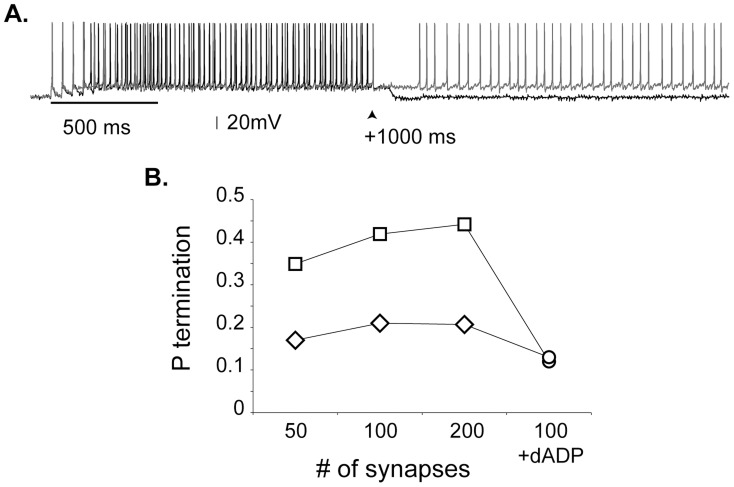
Stability of persistent activity depends on the background synaptic activity and the activation of the dADP current.
A. Indicative traces of persistent activity termination (black) and maintenance (grey) when a second stimulus (100 Hz for 100 ms) arrives 1 sec (arrow) after the inducing stimulus (dADP = 0 mV, iNMDA-to-iAMPA: 2.3). B. Probability of persistent activity termination as a function of the number of synapses delivered to the interneuron (50-100-200) under control condition (iNMDA-to-iAMPA: 2.3, dADP = 0 mV, squares) and in the presence of background synaptic input (iNMDA-to-iAMPA: 1.9, dADP = 0 mV, rhombus). dADP activation (absence of background activity: iNMDA-to-iAMPA: 1.9, dADP = 2 mV, presence of background activity: iNMDA-to-iAMPA: 1.5, dADP = 2 mV) is shown with circles. The different iNMDA-to-iAMPA conditions were used to ensure similar induction probabilities.